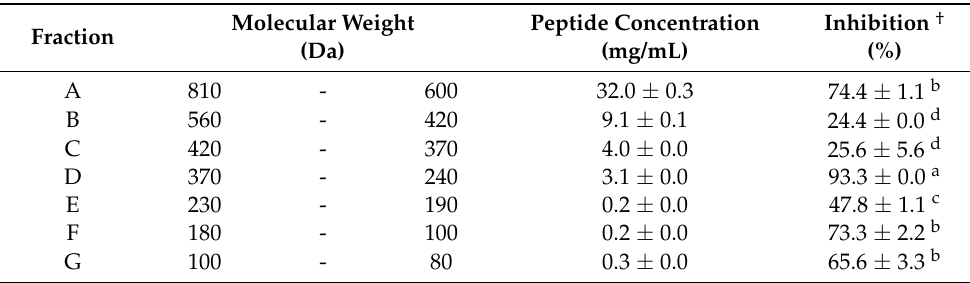
Table 4. Peptide content and HMG-CoA reductase inhibitory activities of the size exclusion chro- matographic fractions obtained from HPP-FH-PR6G *.